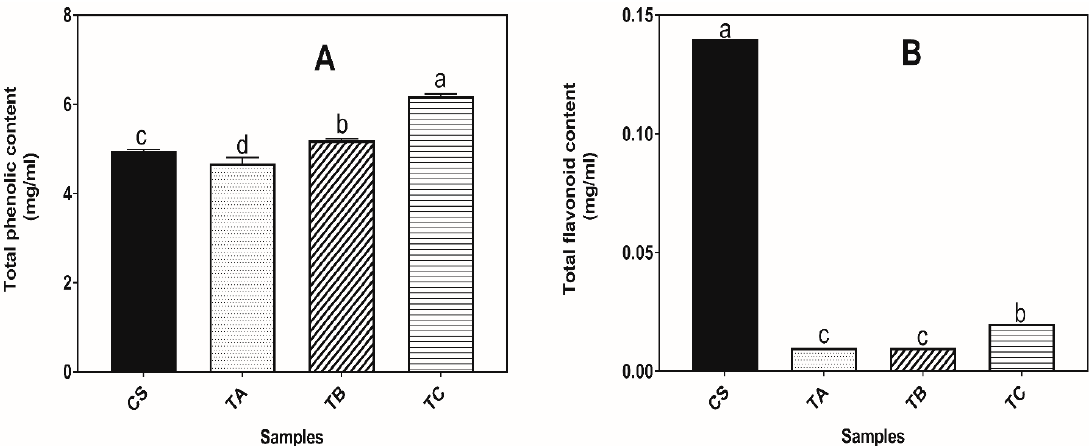
Figure 1. Percentage (mean ± standard deviation, n = 3) of ( A ) total phenolic and ( B ) total flavonoid contents of smoothies (TPC and TFC). Bars with different letters indicate values that are significantly different ( p < 0.05). CS: 45% Pineapple, 40% Banana, 15% Apple; TA: 44.5% Pineapple, 39.5% Banana, 14.5% Apple, 1.5% Moringa leaves; TB: 44% Pineapple, 39% Banana, 14% Apple, 3% Moringa leaves; TC: 43.5% Pineapple, 38.5% Banana, 13.5% Apple, 4.5% Moringa leaves.